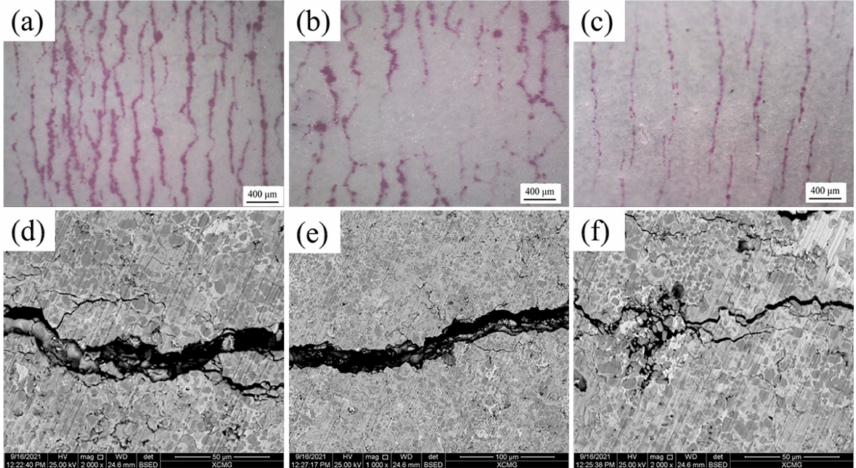
Figure 8. ( a – c ) the penetrating tested surface of No. 1–3 after BFT and ( d – f ) the high magnification image of fatigue